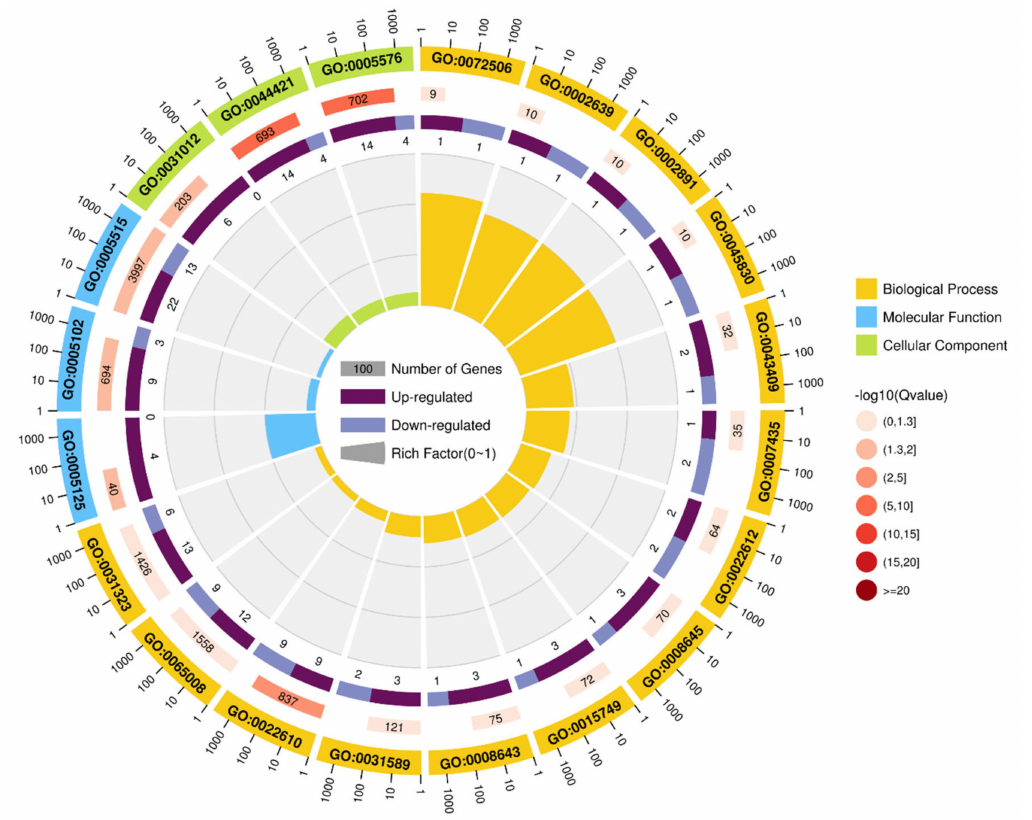
Figure 6. The Gene Ontology (GO) classification of DEGs in 2 groups of bovine adipocytes, transfected with bta-miR-149-5p (n = 3) mimics and mimics NC (n = 3). Each category of GO term was represented with different colors: yellow reflects biological process, green shows cellular component, and blue depicts molecular